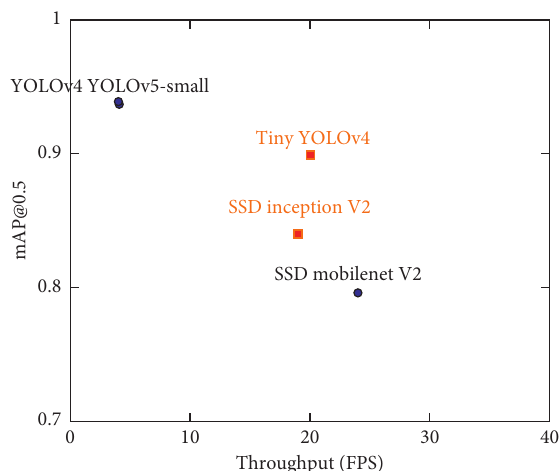
Figure 12: The mean average precision of evaluated models across throughput.